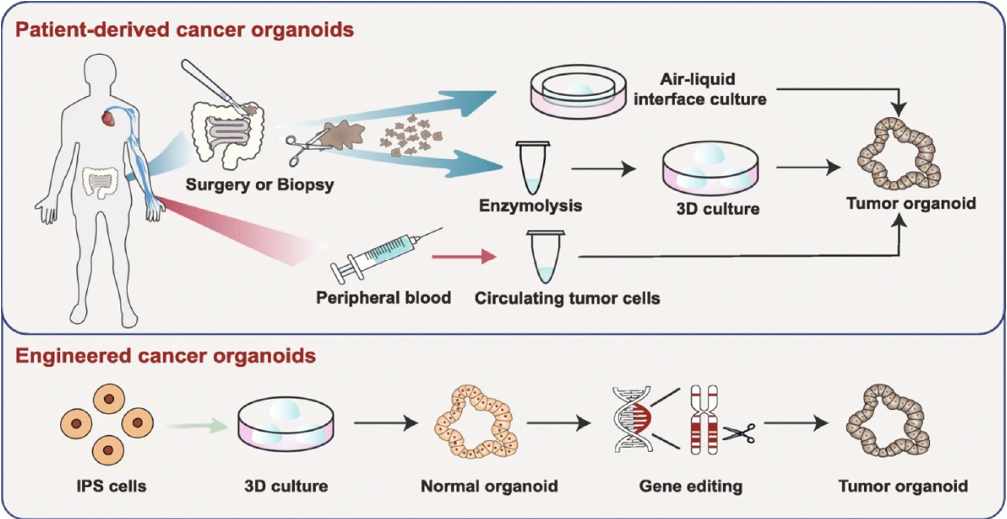
Figure 10. Organoid models toward personalized medicine. Patient-derived cancer organoids can be derived from surgically resected/biopsied tissues and circulating tumor cells. Furthermore, using gene-editing, normal spheroids can be mutated into tumor organoids. Reproduced with permission from [180]. Copyright 2019 Springer Nature.